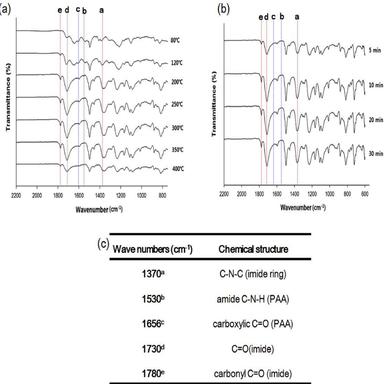
FT-IR spectra of PI films: (a) Changes in peaks due to temperature (°C), (b) changes in peaks due to time (min) at 350 °C, and (c) FT-IR peaks of PAA and PI films.